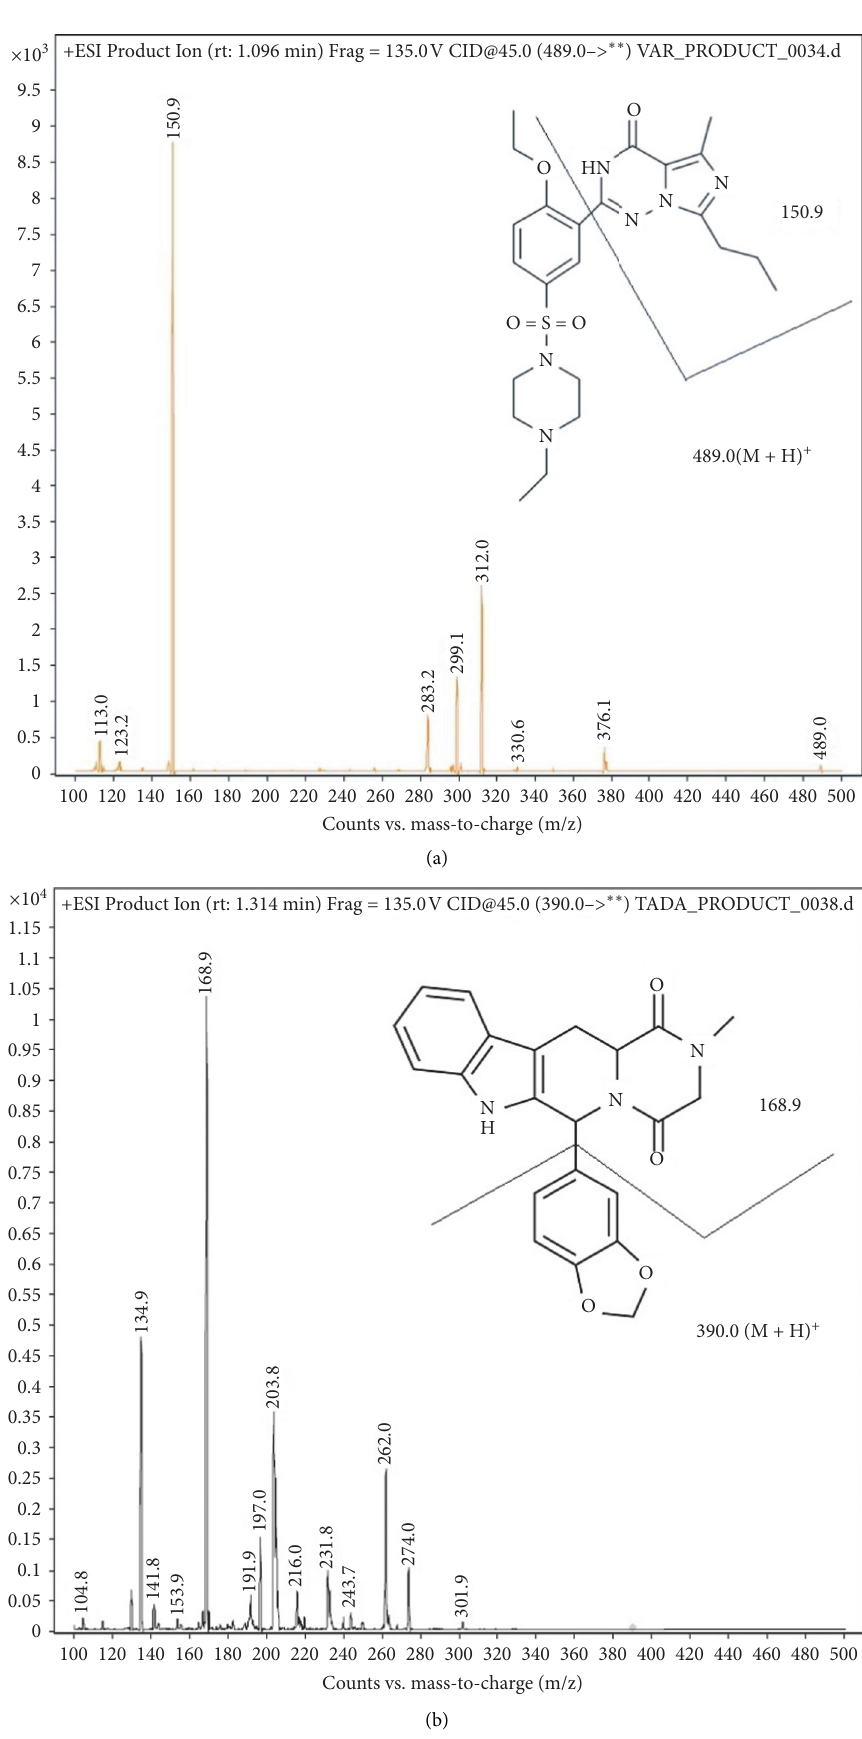
Figure 1: MS/MS spectrum of product ion for (a) vardenafil and (b) tadalafil in positive ion